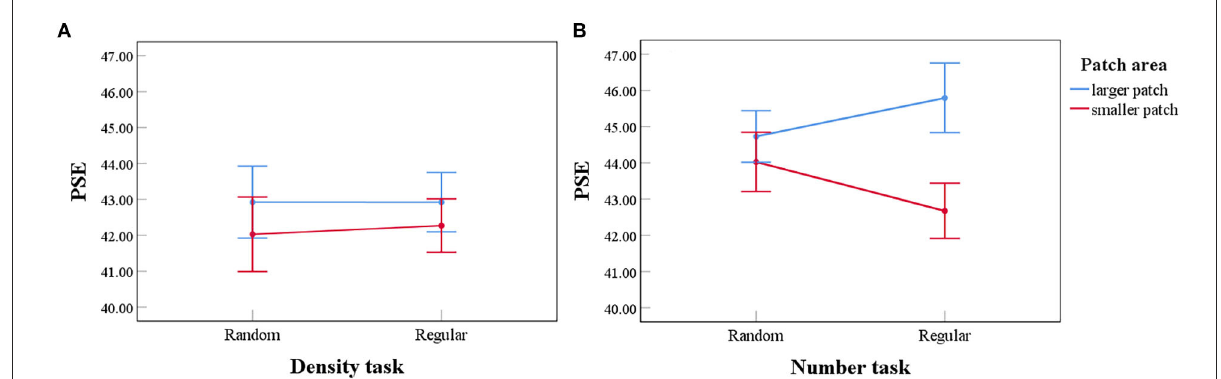
FIGURE5 Results of a 2 (perceived patch area: larger/smaller) × 2 (distribution: random/regular) repeated measures ANOVA in density and number tasks. Error bars represent 1 standard error of the mean. For density tasks (A) , no main effect for the perceived patch area was found. No significant interaction was found, either. For number tasks (B) , there is a main effect for the perceived patch area. A significant interaction was found between perceived patch area and distribution. With regular patterns, a larger patch was perceived to be more numerous.